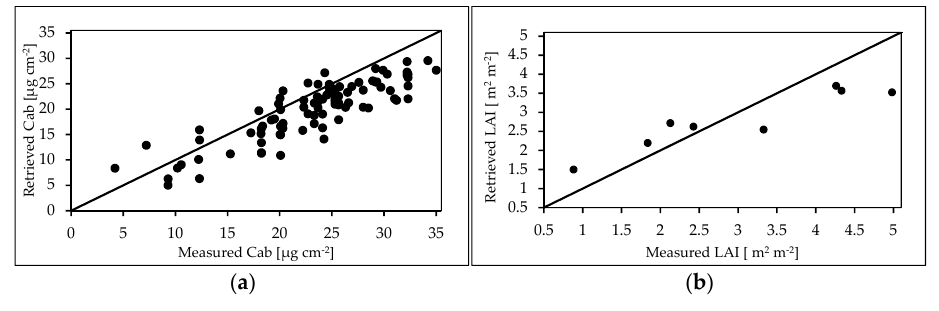
Figure 10. Retrieved versus measured vegetation parameters. ( a ) Cab; ( b ) LAI. Table 5. Evaluation of RTMo model inversion results for LAI ( n = 8) and Cab ( n = 108) estimation.